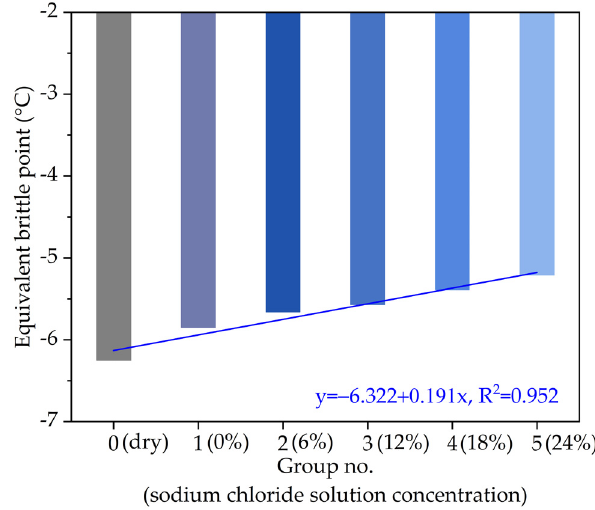
Figure 6. The variation of equivalent brittle point with different chloride salt concentrations.